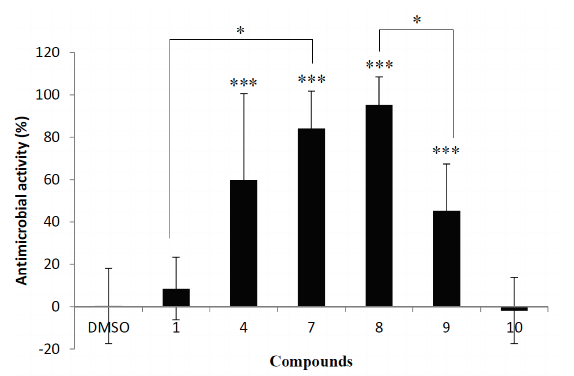
Figure 5. Antimicrobial activity of synthesized dimeric flavan-3-ols ( 1 , 4 , and 7 – 10 ) against S. cerevisiae. Comparison of antimicrobial activity (%) at final concentration of 50 μ M after 20 h incubation. 200 μ L of culture medium of S. cerevisiae at O.D. 600nm 0.25 was treated with 1 μ L of DMSO solution of 1 , 4 , and 7 – 10 at final concentrations of 50 μ M. DMSO was used as a negative control. Error bars represent standard deviation of the mean ( n = 6). *** p < 0.001 vs. DMSO-treated groups, asterisks indicate * p < 0.001 in Student’s t test.